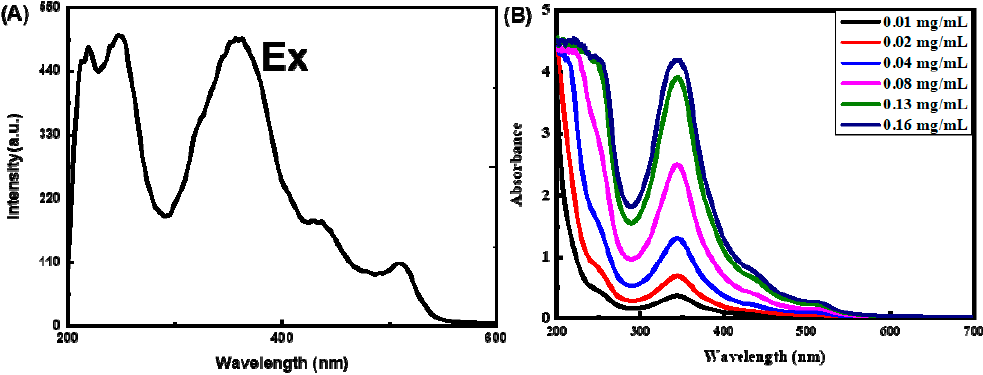
Figure 2. ( A ) The excitation spectrum of the N-CQDs and ( B ) ultraviolet spectrum of different concentrations of N-CQDs.